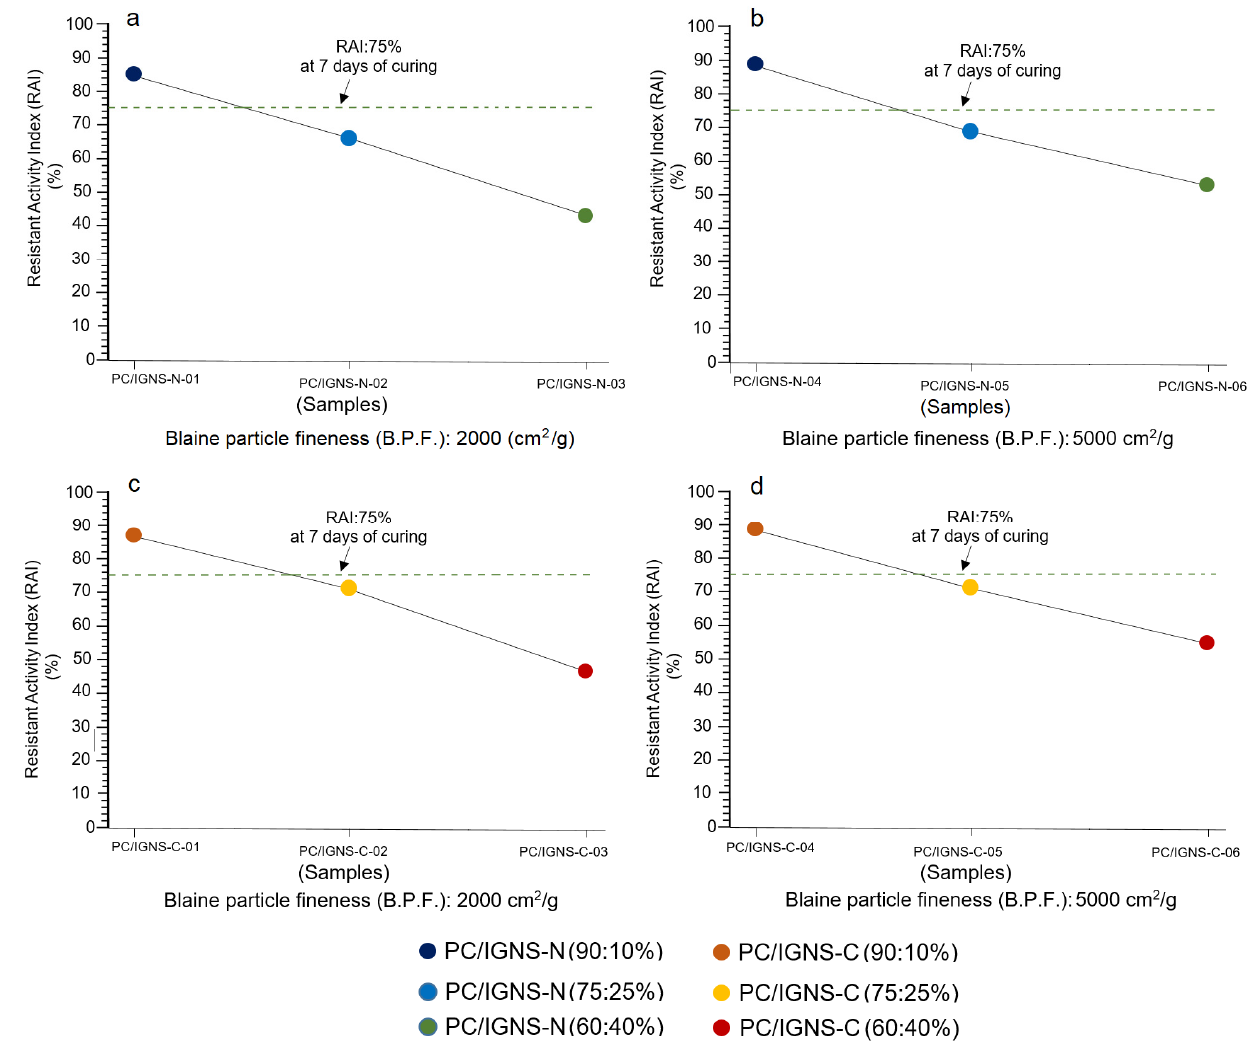
Figure 7. Evolution of the Resistant Activity Index (RAI) in mortar specimens made with mixtures of Portland cement (PC) and ignimbrite (PC/IGNS) in natural state ( a , b ) and calcined ( c , d ), and with fineness of IGNS particles of 2000 and 5000 cm 2 /g. RAI has been calculated for 7 days of curing.